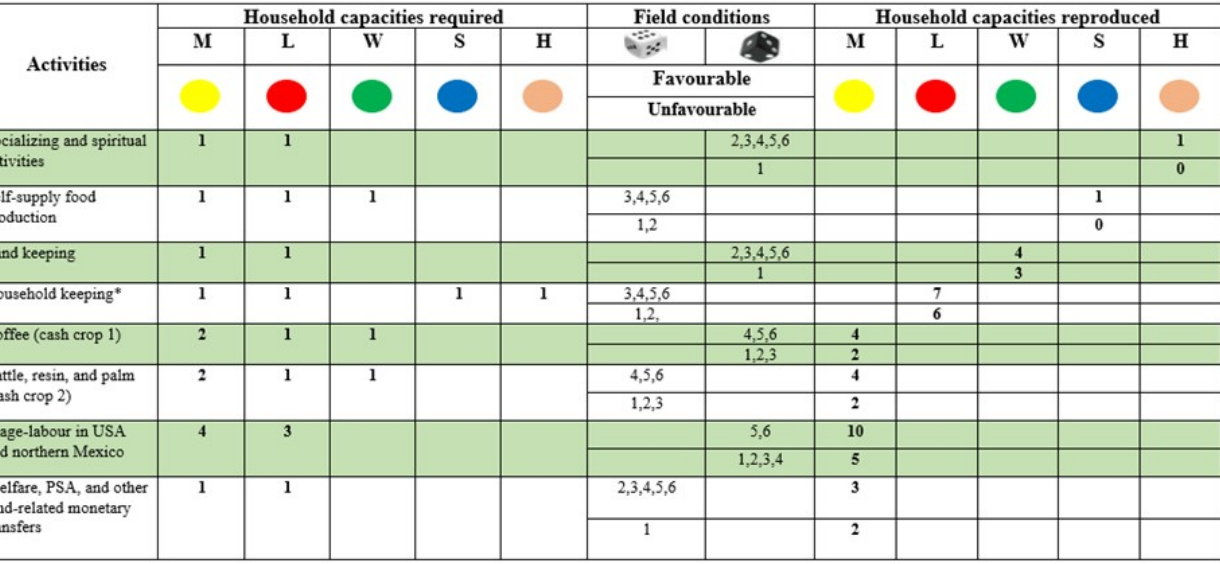
Fig. 5. Household capacities required for undertaking each activity, outcomes of a dice throw representing favorable or unfavorable social field condition for each activity, and household capacities reproduced as a result of each activity.